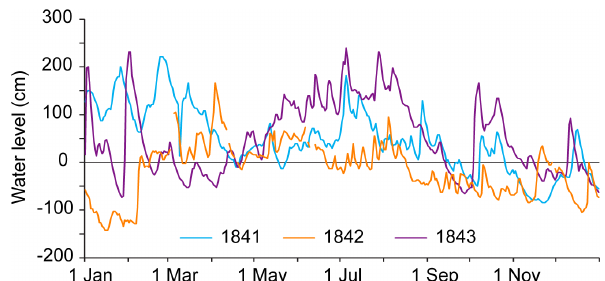
Figure 9. Annual fluctuations in daily water levels of the Danube at Vienna in the profile of the Great Danube Bridge during the years 1841, 1842, and 1843 (data extracted from Wiener Zeitung